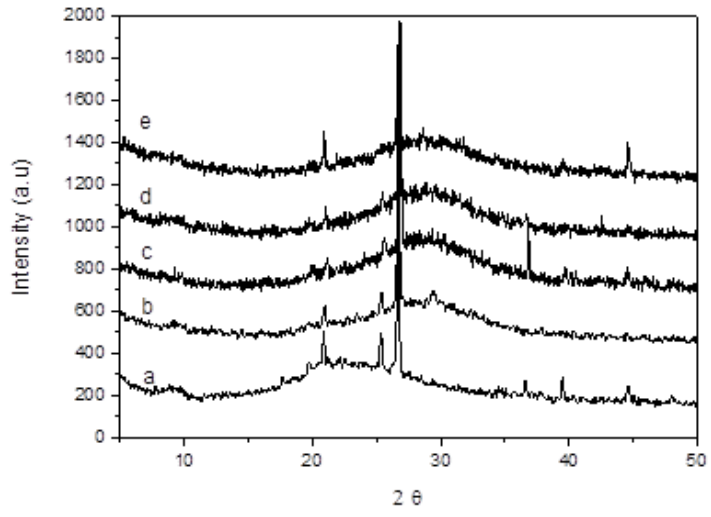
Figure 4 . Diffractograms ( a ) Metakaolin; geopolymeric mortars cured at 50 °C: ( b ) 0%wt FBA, ( c ) 10% wt FBA ( d ) 20% wt FBA ( e ) 30% wt FBA.